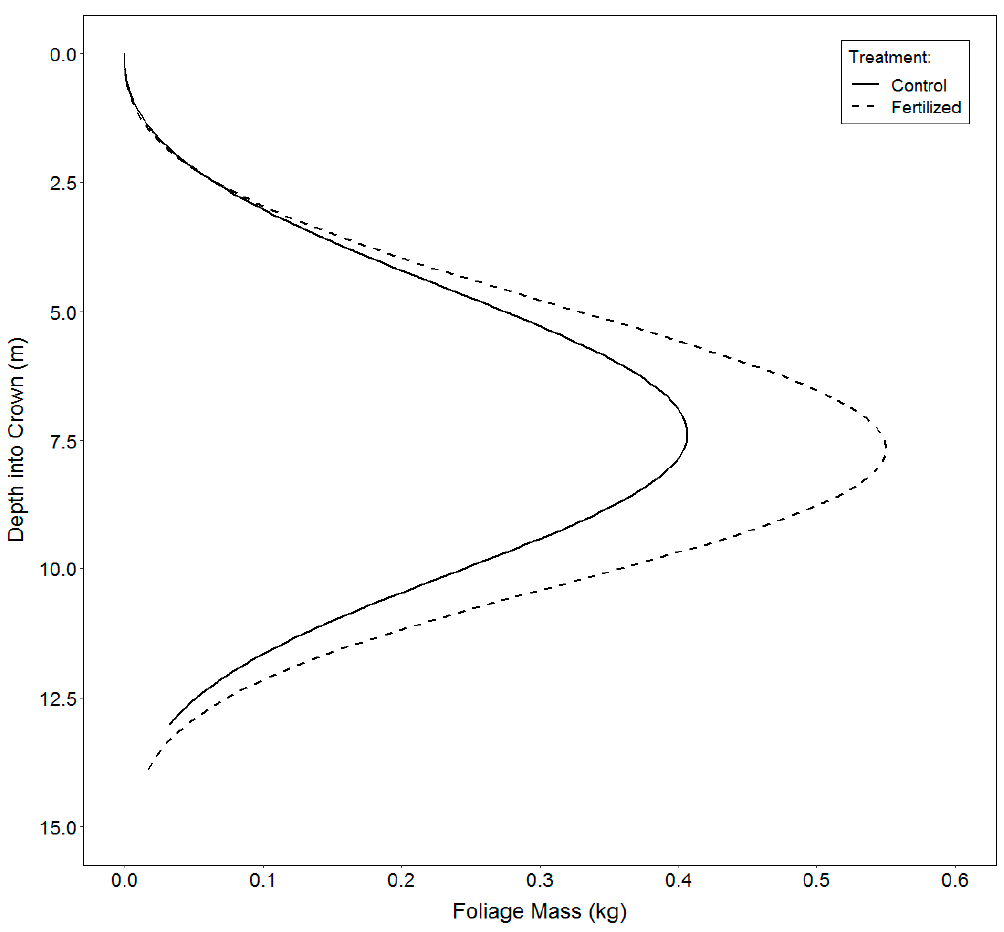
Figure 6. Effect of nitrogen fertilization on vertical foliage distribution over depth into crown (DINC; m) as modeled with a right-truncated Weibull distribution (control = solid line; fertilized = dashed line). Vertical foliage distribution is represented as absolute foliage mass (kg). Distributions were standardized to the average tree size by treatment in the study (See Table 1). RDINC = 1 at crown base and RDINC = 0 at tree tip.